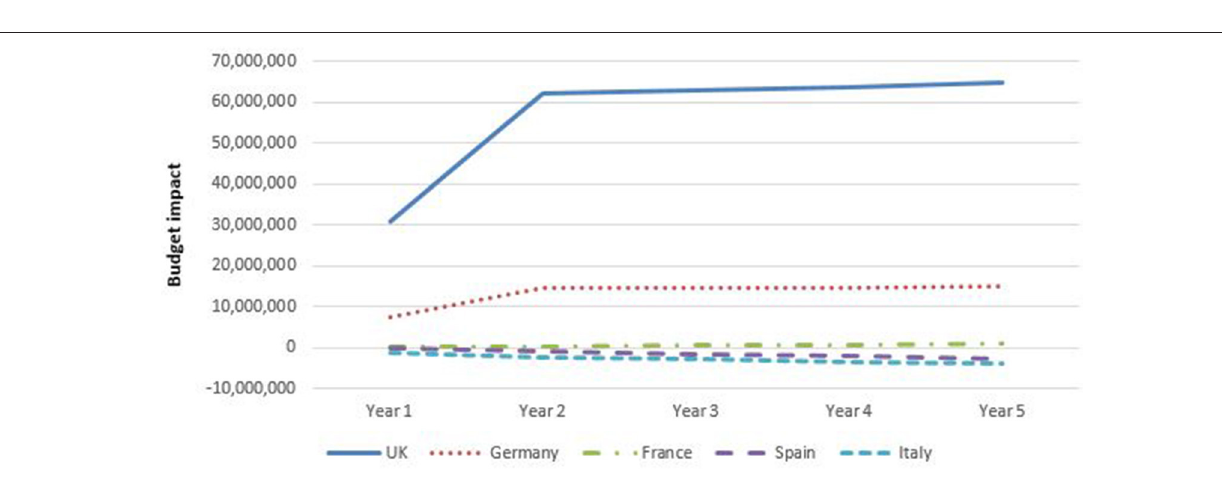
FIGURE 7 | Budget impact of adopting biosimilar infliximab for gastroenterology per country, base case (including vedolizumab for Germany and United